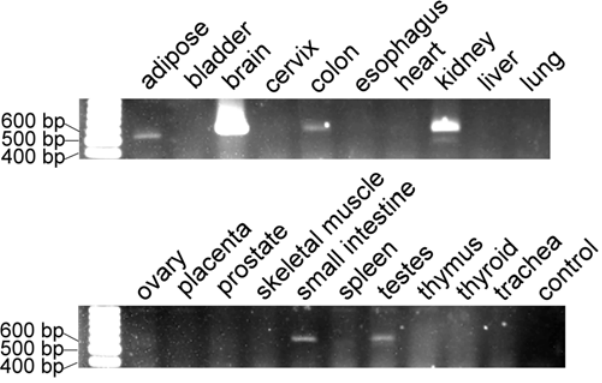
Figure 1. Tissue distribution of cadherin-9. An RT-PCR analysis of a human tissue RNA panel revealed that, apart from the brain,